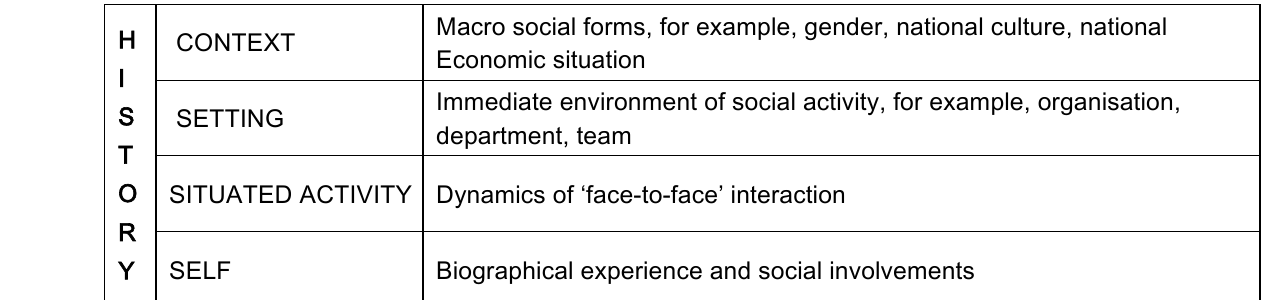
Figure 3: Research map (Adapted from Layder,